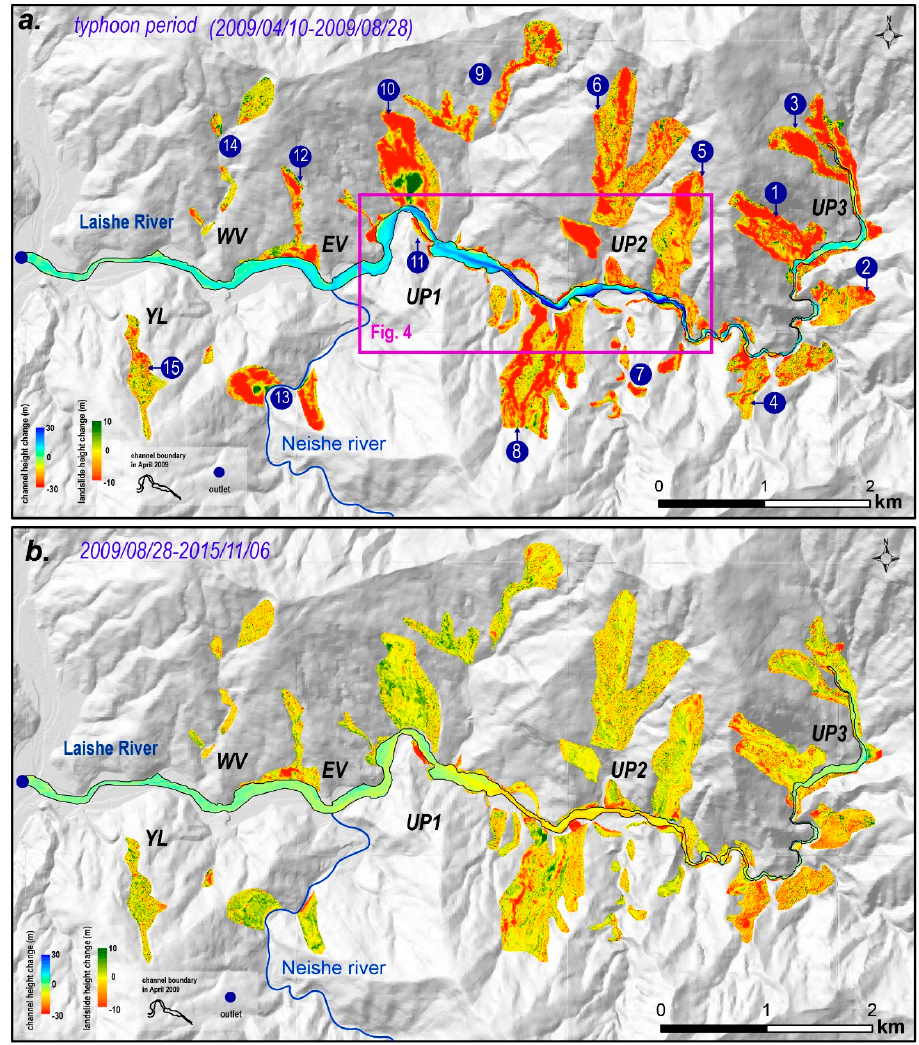
Figure 3. Distribution of height changes obtained from the DEM by the UAV survey ( a ) 10 April 2009–28 August 2009 ( b ) 28 August 2009–6 November 2015. Blue dots denote the outlet of Laishe